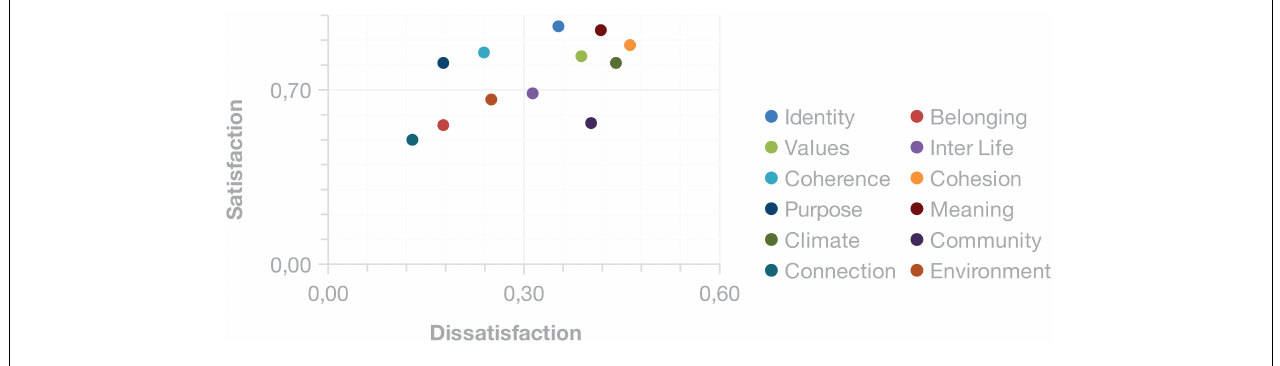
FIGURE 2 | Factors classification for the organization.